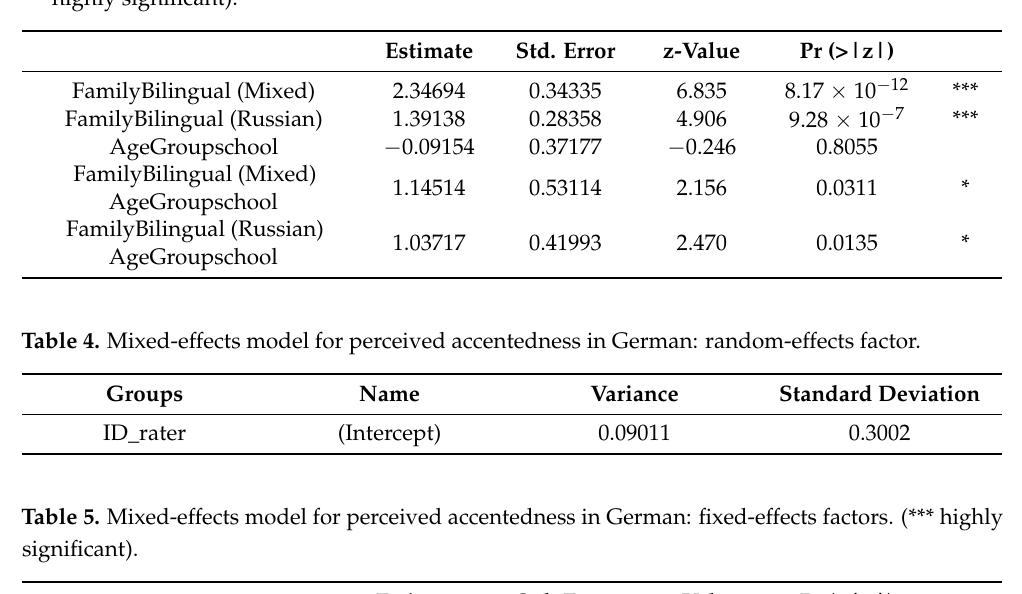
Table 3. Mixed-effects model for perceived accentedness in Russian: fixed-effects factors (* signifcant, *** highly significant).